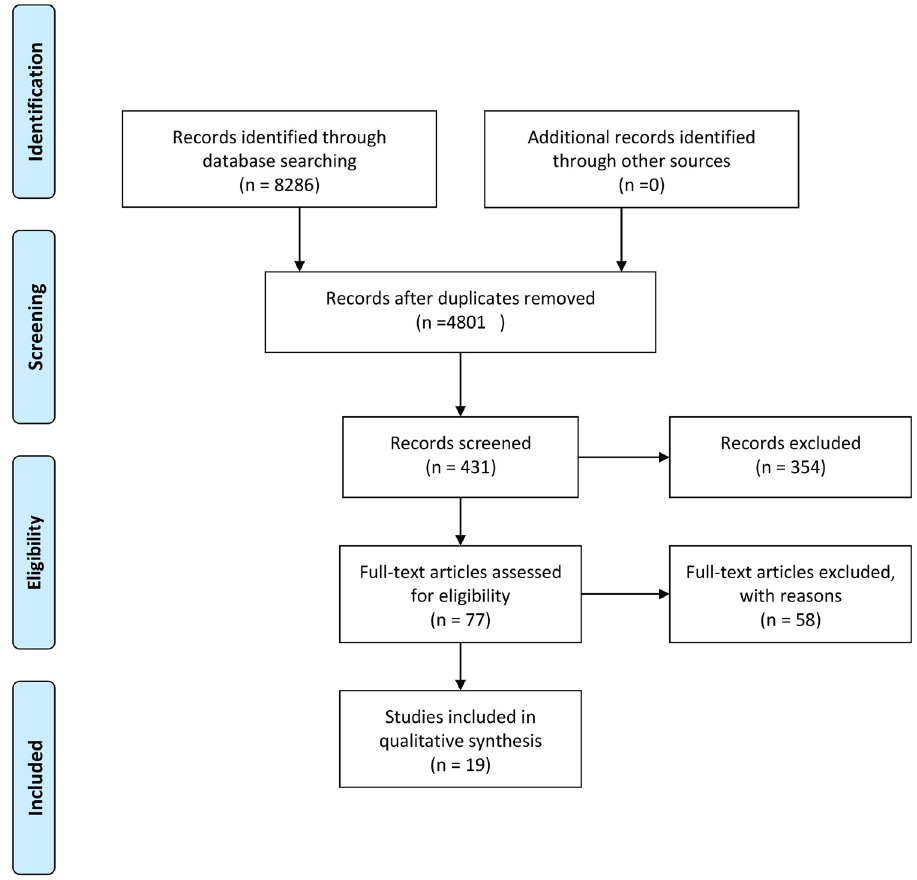
Fig 1. Flow diagram of article selection according to